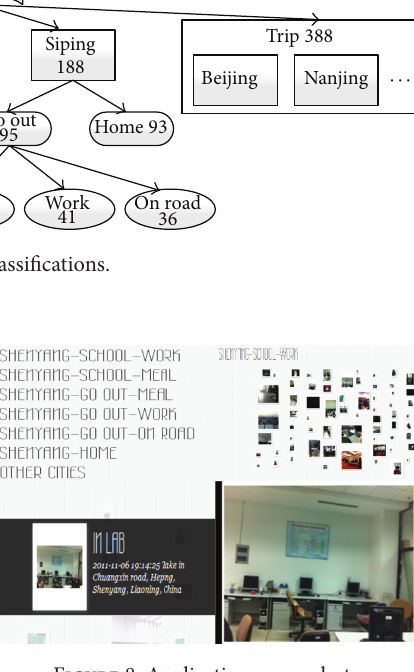
Figure 8: Application